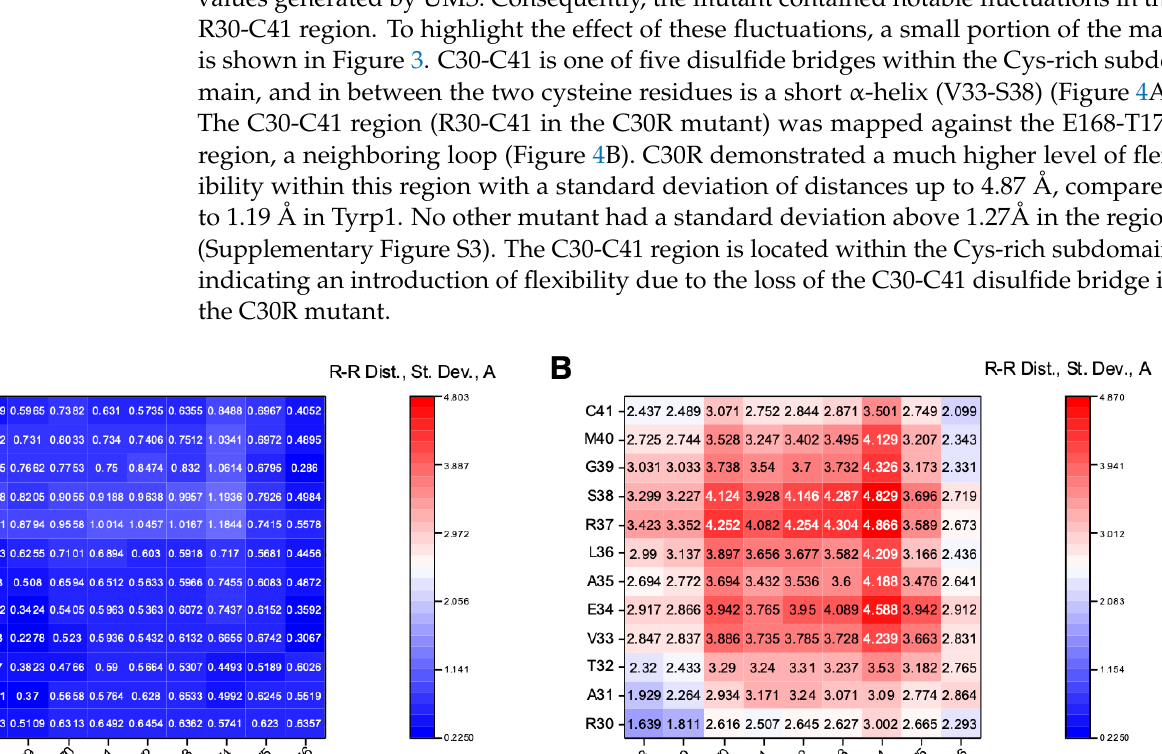
Figure 4. Compared region of residue-residue distance maps in Tyrp1 and C30R mutant. Homology models of Tyrp1 ( A ) and C30R ( B ) were equilibrated using MD in water for 100 ns. Residues in red indicate the intact and the broken (C30R) disulfide bridge. The residues in red and green indicate the focused region of the residue-residue distance maps in Figure 2. 2.4. Free Energy Landscapes Free energy landscapes are usually obtained to investigate the relative stabilities of different conformational states in a biomolecule concerning a conformation coordinate of interest [17]. In our work, free energy landscapes were created for Tyrp1 and two mutant variants, D308N and R326H, which are expected to form stable protein structures. A macro was created in YASARA to measure the distance between T391 and both Y362 and N378 for every simulation snapshot (Table 2). T391, Y362, and N378 are the residues ex- pected to form the bottleneck for the passage of the DHICA molecule (Radius = 3.45 Å). Tyrp1 had a mean of 7.37 Å with a standard deviation of 1.05 Å for the Y362-T391 distance and a mean of 8.47 Å with a standard deviation of 1.28 Å for the N378-T391 distance. D308N had a mean of 8.45 Å with a standard deviation of 0.65 Å for the Y362-T391 dis- tance and a mean of 10.62 Å with a standard deviation of 1.65 Å for the N378-T391 dis- tance. R326H had a mean of 9.90 Å with a standard deviation of 1.50 Å for the Y362-T391 distance and a mean of 9.93 Å with a standard deviation of 1.65 Å for the N378-T391 dis- tance. Distances were inputted into the Weighted Histogram Analysis Method (WHAM)